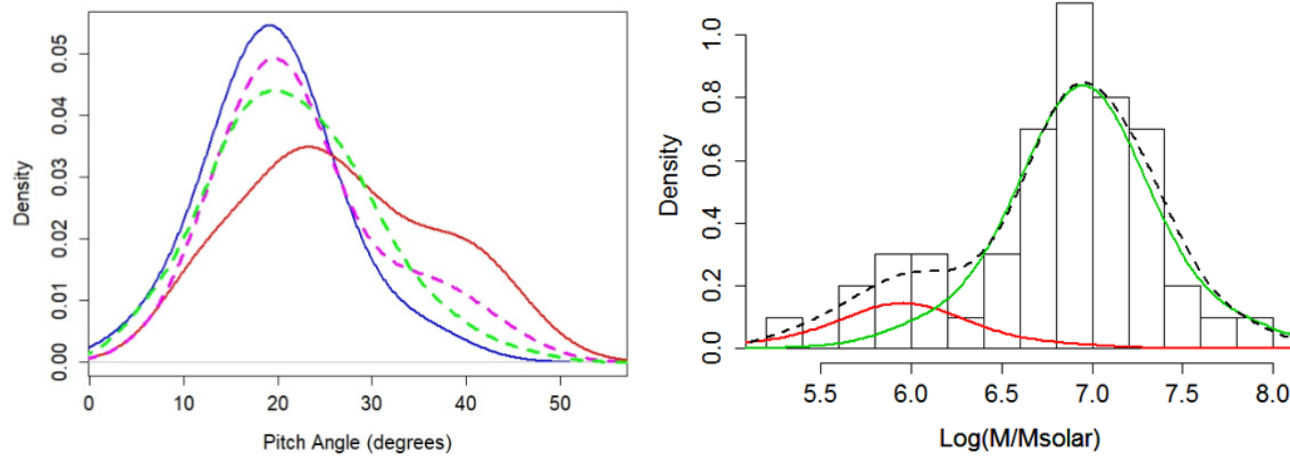
Figure 15. ( Left ) Corrected PADFs of key subsamples: bright sample ( ), faint sample ( ), faint subsample of Hubble types Sa–Sc ( ), and the faint subsample of Hubble types Scd & Sd ( ). From this figure it is clear that while the Scd & Sd type galaxies make up a small fraction of the faint sample, they are the cause of most of the behavior at the tail of the distribution. It is also apparent that the excess peak height in the faint sample is a result of the comparative overabundance of Hubble type Sc galaxies, which cluster strongly around the peak. ( Right ) BHMF of the faint sample decomposed into low-mass ( ) and high-mass ( ) populations. Curves are semi-parametric fits to the cluster data. The dashed line ( ) is the KDE of original